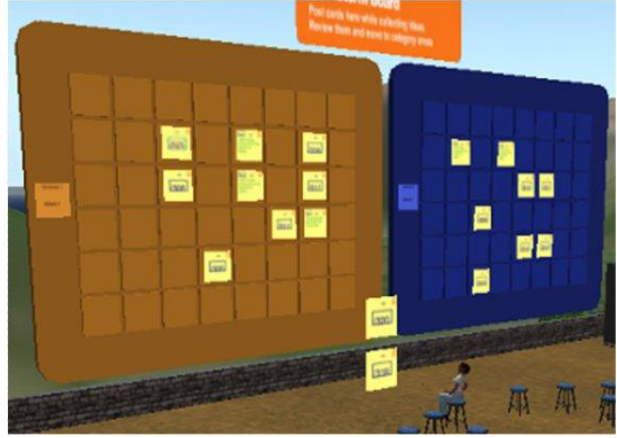
Figure 1. The framework for virtual notes is used in Sametime 3D brainstorming sessions [15].